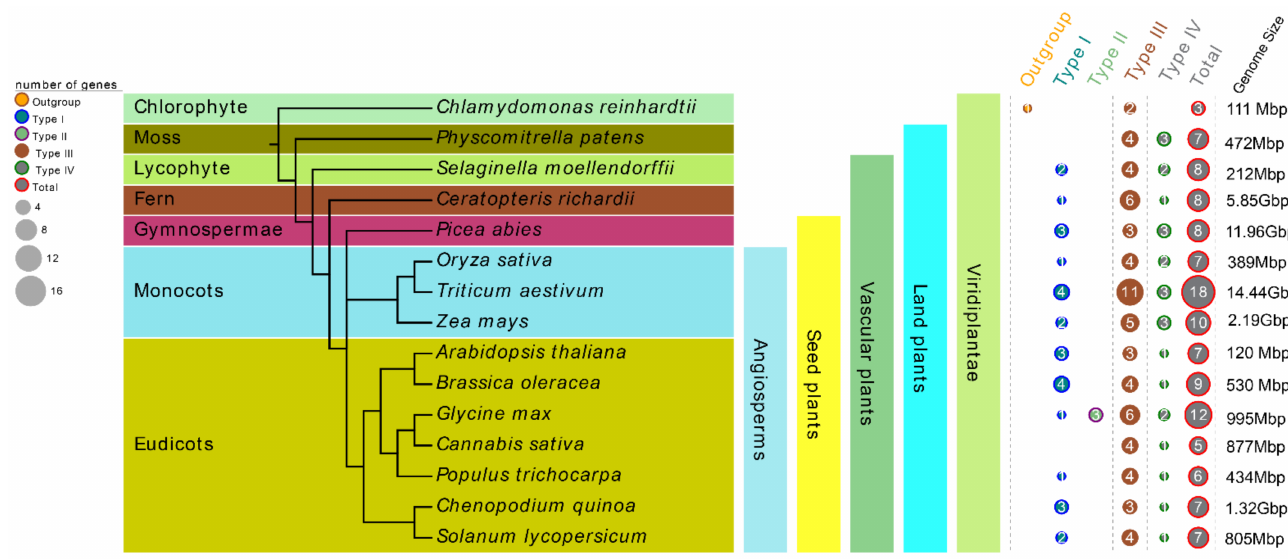
Figure 1. Comparison of the distribution of CHIs among fifteen selected green species representing a broad range evolutionary time. The CHI type class was classified according to the phylogeny